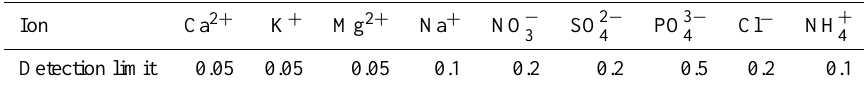
Table 2. Detection limits of the different ions in mg/l.